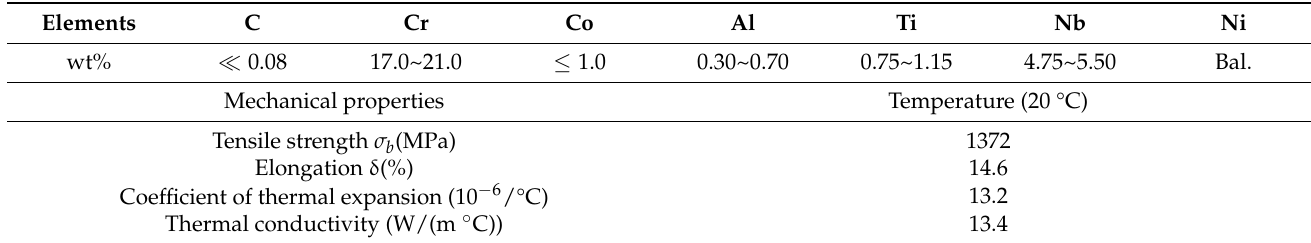
Table 1. Chemical composition and mechanical properties of